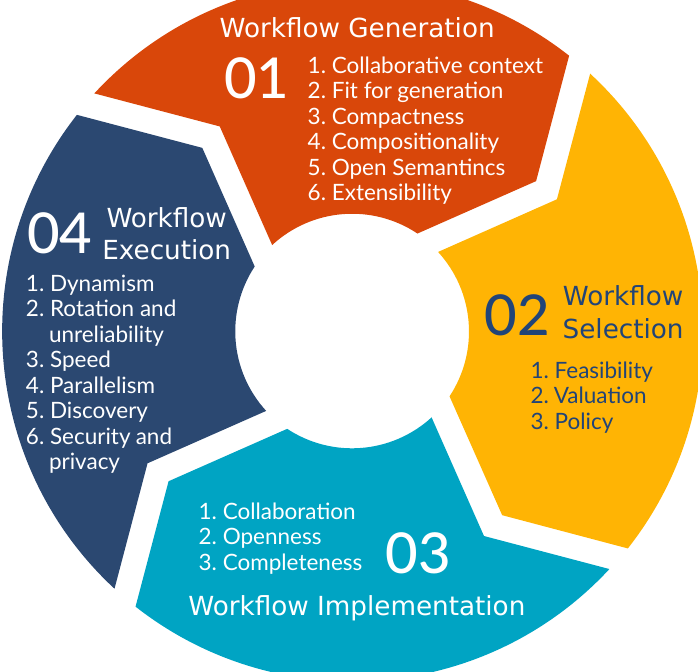
Figure 3. Workflow lifecycle phases and their internal challenges